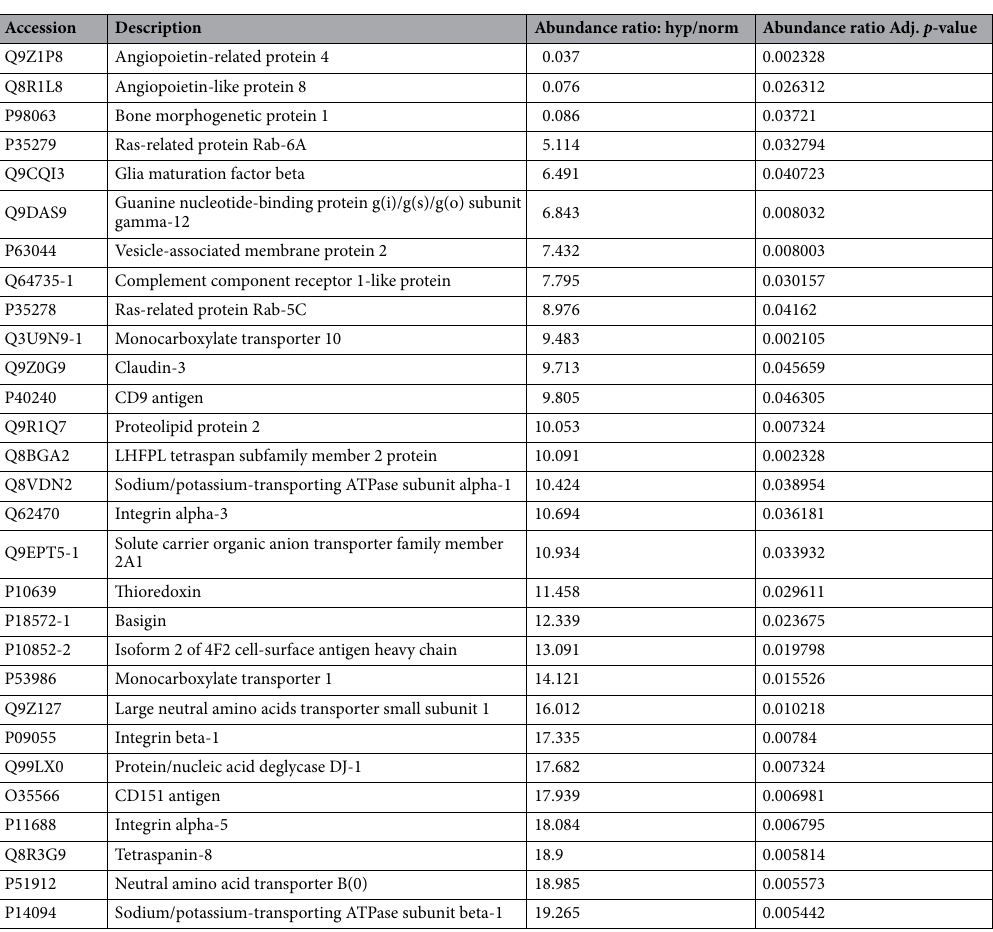
Table 2. Proteins significantly different in abundance between hypoxic and normoxic